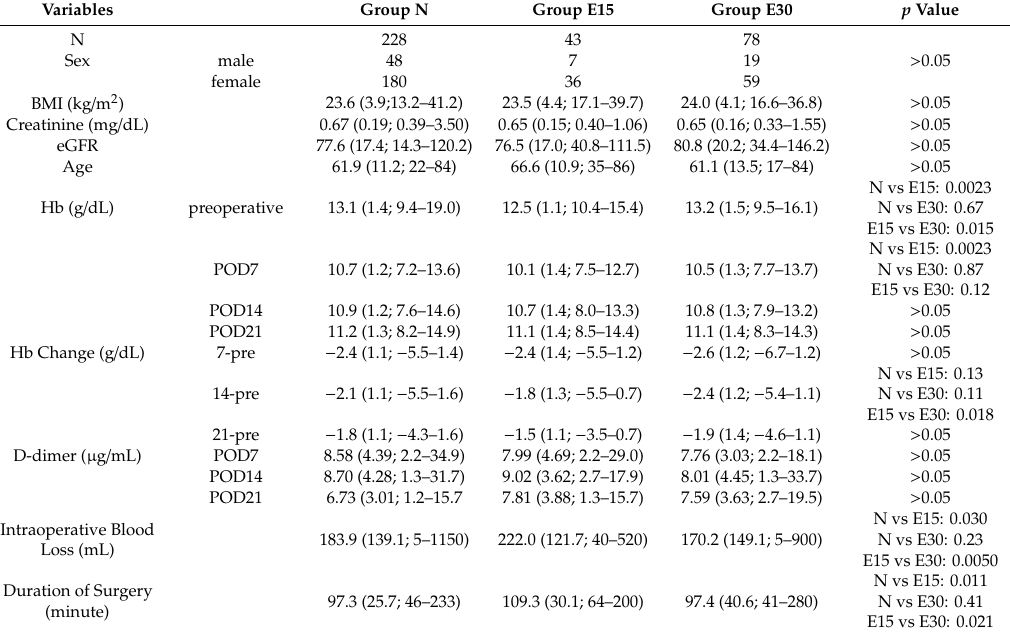
Table 1. Demographics and blood test results for each group.